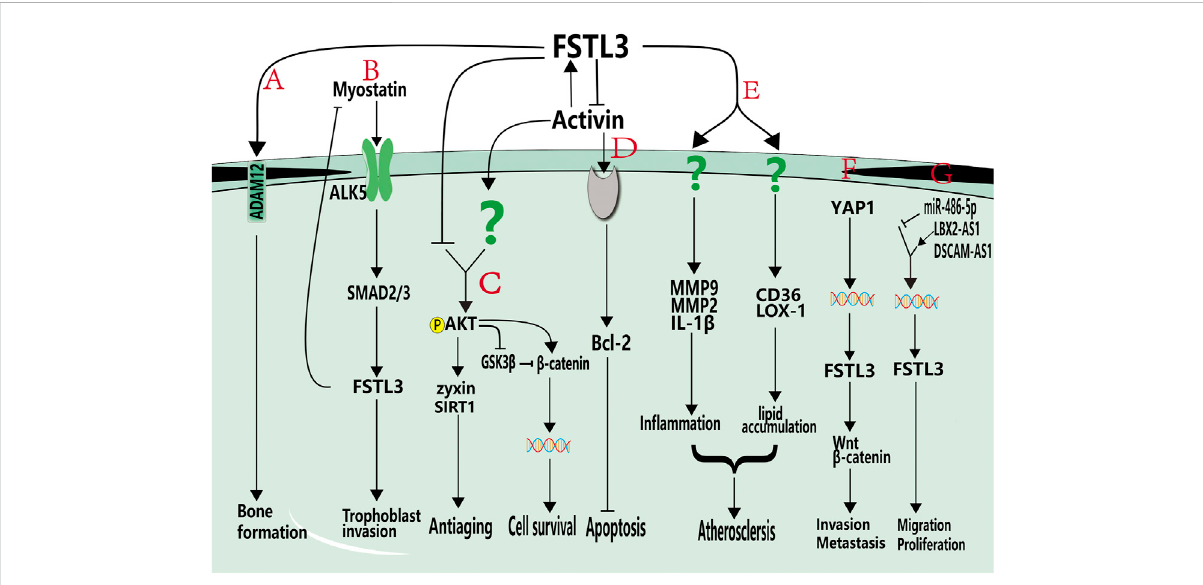
FIGURE 2 Roles of FSTL3 in non-tumor pathophysiologies and cancers. (A) . FSTL3 can bind to ADAM12 and promote bone formation. (B) . Myostatin promotestrophoblastic invasionbyactivating theALK5-SMAD2/3signaling pathwayand activatedSMAD2/3 pathway canincreasetheexpressionof FSTL3. (C) . FSTL3 inhibits AKT phosphorylation, decreases β -catenin expression, and inhibits cell growth. Additionally, FSTL3 inhibits AKT-mediated activationofzyxinandSIRT1,therebyreducingantiagingeffects. (D) .FSTL3inhibitsactivinAexpression,whichdecreasestheexpressionofBcl- 2. (E) . FSTL3 may be induced by oxLDL, upregulates CD36 and LOX-1 and promote MMP9, MCP-1, and IL-1b expression, cause lipid accumulation andin fl ammatorydevelopment,andpromotesthedevelopmentofatherosclerosis. (F) .Incancercells,FSTL3canserveasabridgingmoleculeinthe crosstalk between YAP1 and β -catenin signaling pathways. The activation of YAP1 can induce FSTL3 expression, and high expression of FSTL3 then activates β -catenin signaling pathways and promotes invasion, migration and metastasis of cancer cells. (G) . DSCAM-AS1 and LBX2-AS1 positively regulate the expression of FSTL3 and promote proliferation and migration, and miR-486-5P negatively regulates the expression of FSTL3. Grey components indicate unknown receptors. Colored helical structures represent nuclei. Question marks represent unknown pathways or